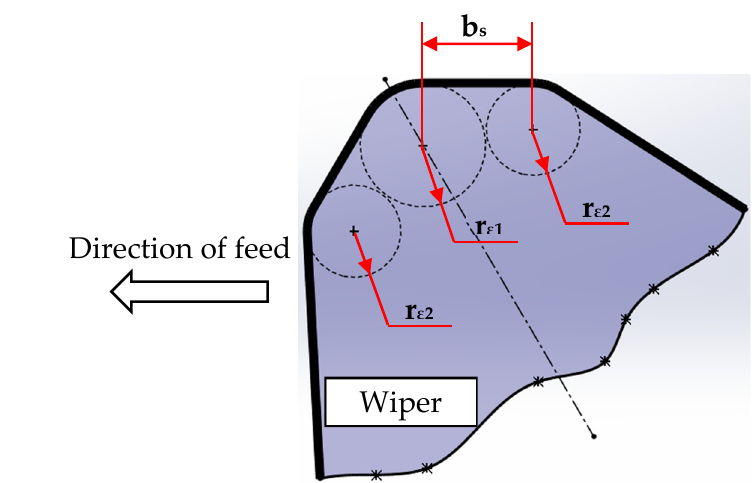
Figure 7. Geometry of wiper insert.